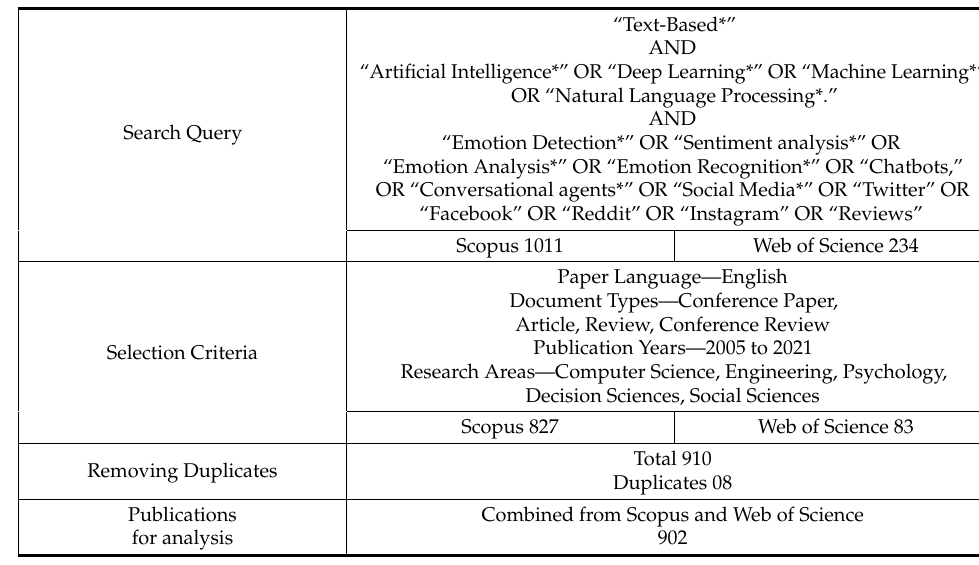
Table 4. Representative data collection